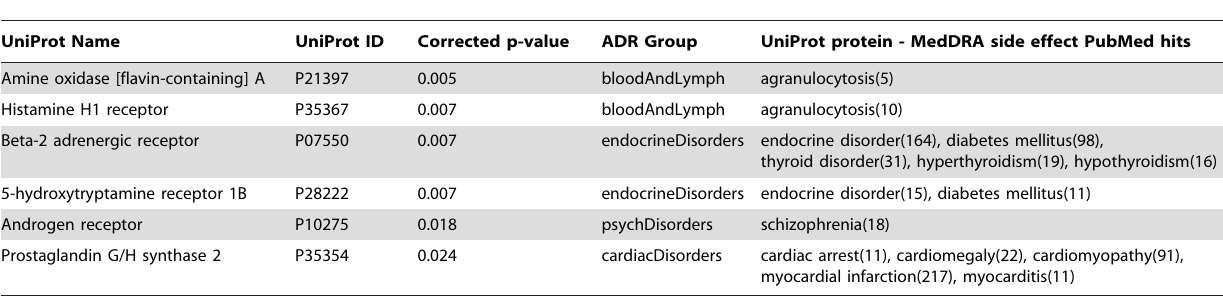
docking score matrix and the logistic regression models to derive associations between ADR groups and proteins. Only 21% (87 out of 409) of the drug-protein binding features involve known protein targets of the drug subset, providing a significant probe of off- target effects. In Table 1, side-effect protein pair-wise associations are shown rank-ordered in ascending order, according to that feature’s p-value. For each entry we list the UniProt name and ID of the drug-binding protein, the PDB ID for the protein target used in docking, the p-value, the corresponding q-value to indicate the FDR for that feature, and the beta coefficient in the ‘‘best’’ model. Furthermore, the variable selection capacity of L1- regularization was employed, so that a protein feature must have a non-zero beta coefficient in order to have been included in Table 1. Finally, for inclusion in Table 1, the ADR-protein association needed to pass the manual review of PubMed evidence. In the last column of Table 1, the level of evidence from PubMed that supports the ADR-protein correlations is shown. For a specific putative ADR-protein entry in Table 1, Table 2. ADR-protein association derived from models built using the 560 6 16 GBSA-corrected virtual screening panel.